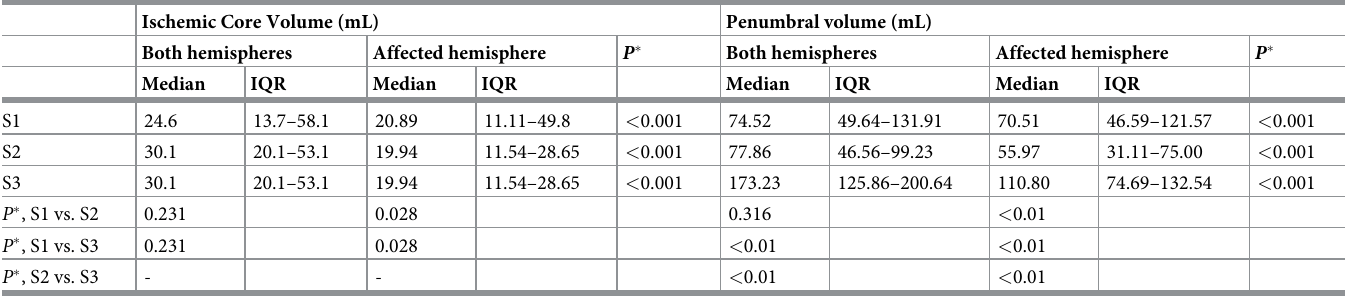
Table 1. Comparison of ischemic core and penumbral volumes (in